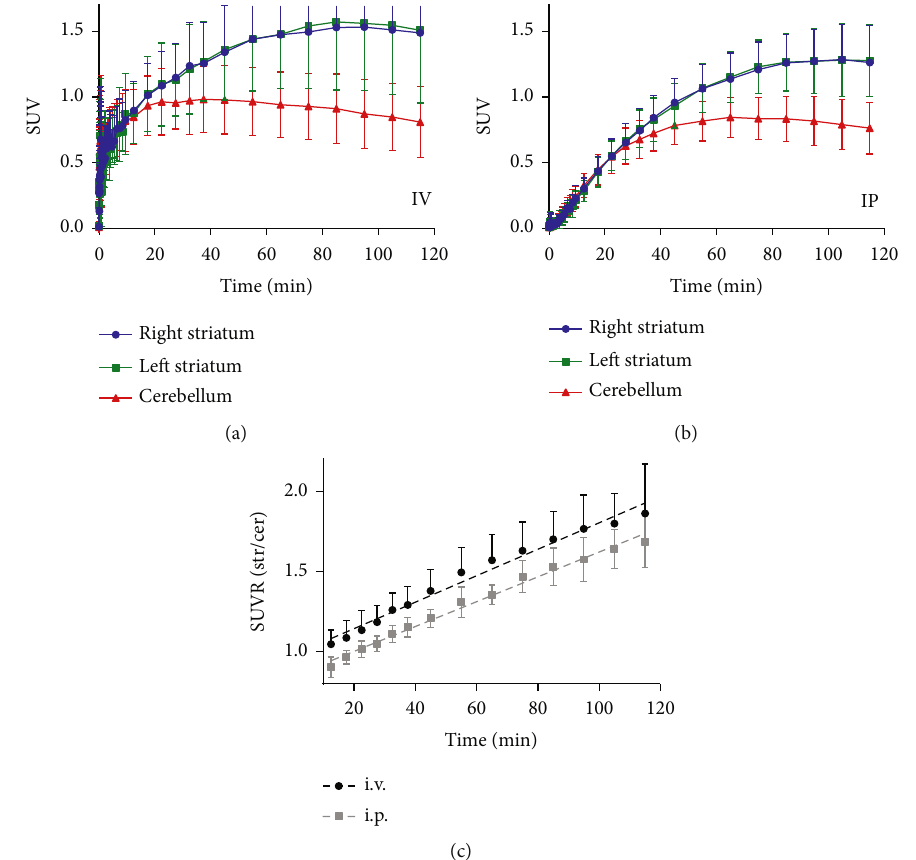
Figure 1: Time-activity curves and SUVR showing the e ff ect of the radiotracer injection method on [ 18 F]-FDOPA uptake and loss over time. (a, b) TAC showing SUV of [ 18 F]-FDOPA activity over time within the right striatum (blue circles), left striatum (green squares), and cerebellum (red triangles) following intravenous ((a) i.v., N = 12 ) or intraperitoneal ((b) i.p., N = 13 ) administration. Values are mean ±S : D : (c). SUV ratio (SUVR) between the striatum (Str) and cerebellum (Cer) over time following i.v. or i.p. injection. Dashed lines show the best- fi t linear regression. Values are mean ± S : D